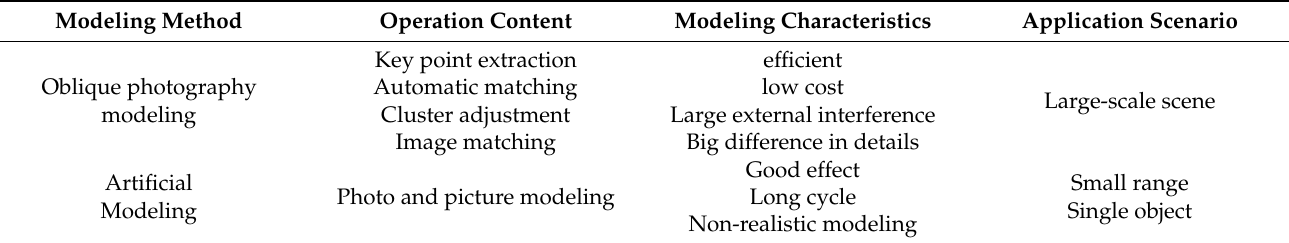
Table 2. Comparison of modeling